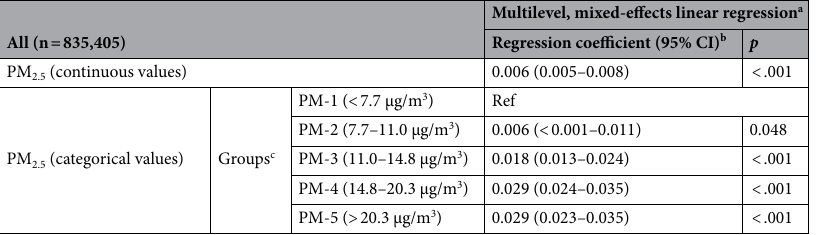
Multilevel, mixed-effects linear regression a Regression coefficient (95% CI) b